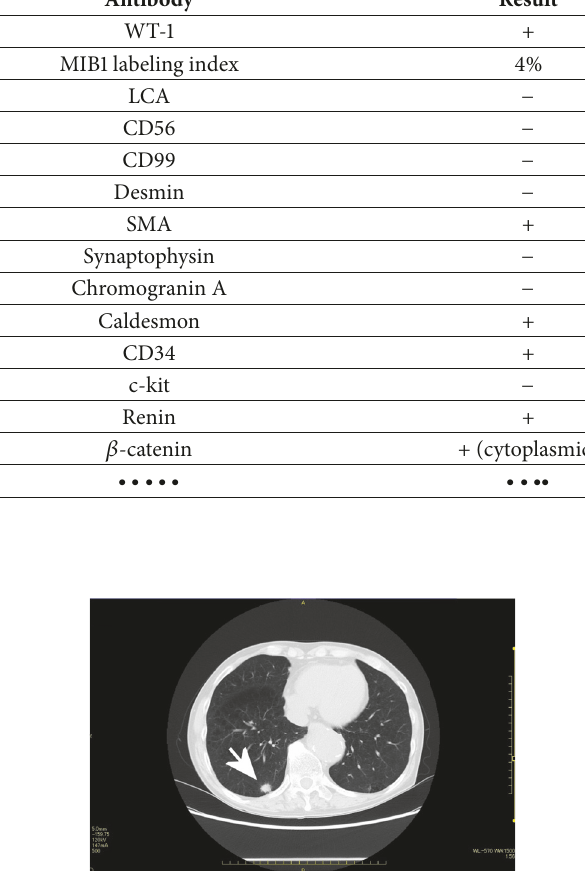
Figure 1: CT image showed right renal mass (arrow). Figure2:CTimageshowedrightlungmasssuspectedformetastasis